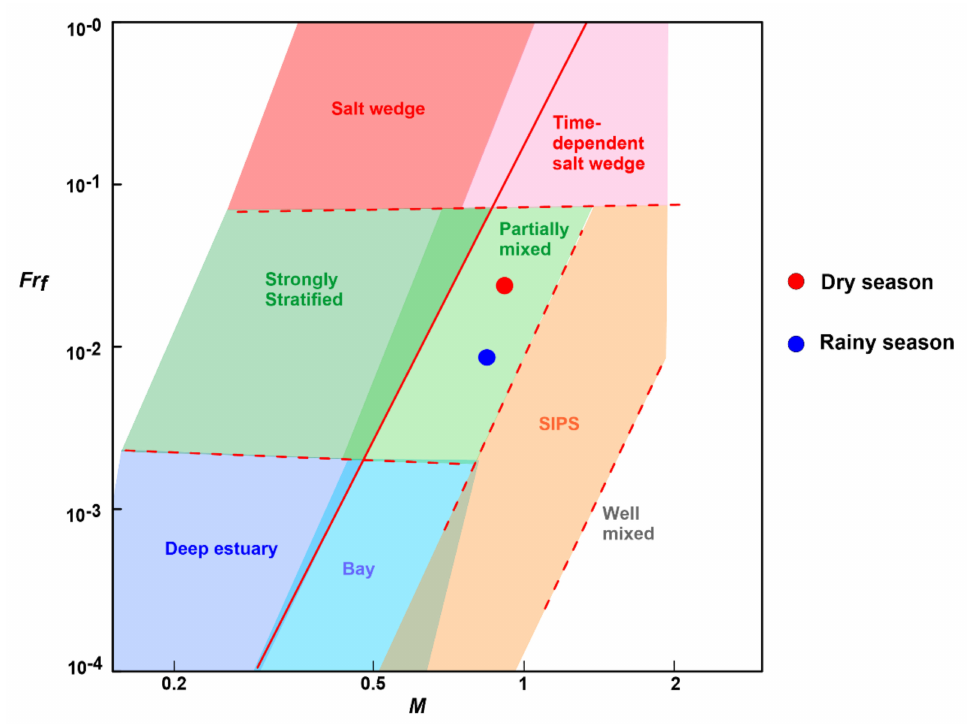
Figure 9. The Gurupi estuary in estuarine parameter space (diagram following the classification of [15]). The blue point represents the rainy season and the red point represents the dry